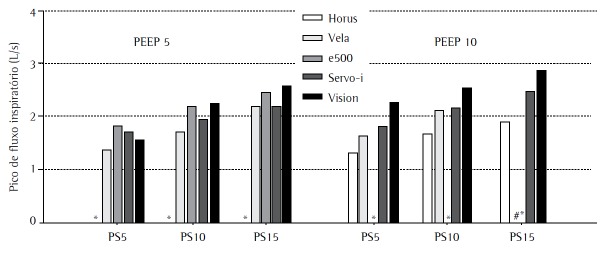
 Pico de fluxo inspiratório de cinco dos ventiladores testados. Medidas
com positive end-expiratory pressure (PEEP, pressão expiratória final
positiva) de 5 cmH2O (PEEP5) e 10 cmH2O (PEEP10) estão à esquerda e à
direita, respectivamente. As medições foram feitas em níveis de pressão de
suporte de 5, 10 e 15 cmH2O (PS5, PS10 e PS15, respectivamente). *Em virtude
de autodisparo, não foram realizadas medidas com o ventilador Horus em PEEP5
nem com o ventilador e500 em PEEP10. #Em virtude da limitação do modelo
pulmonar, o ventilador Vela não foi testado com PEEP10 e PS15.